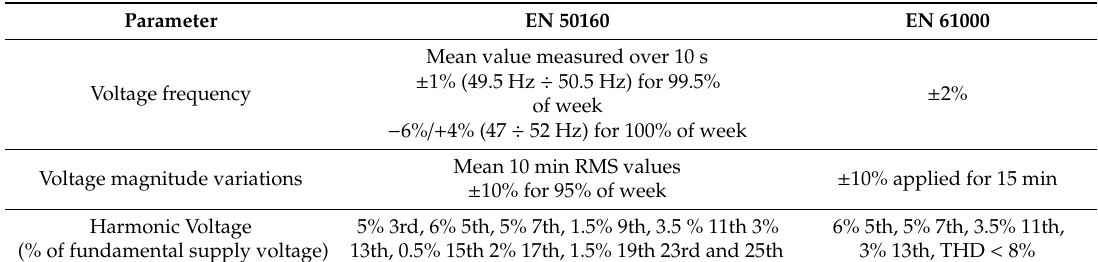
Table 1. Values of International Standards for power quality (PQ)